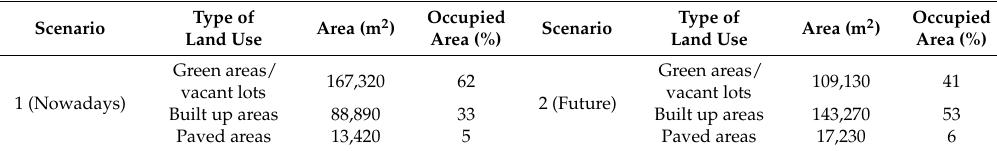
Table 3. Land use for Scenarios 1 (nowadays) and Scenarios 2 (future).